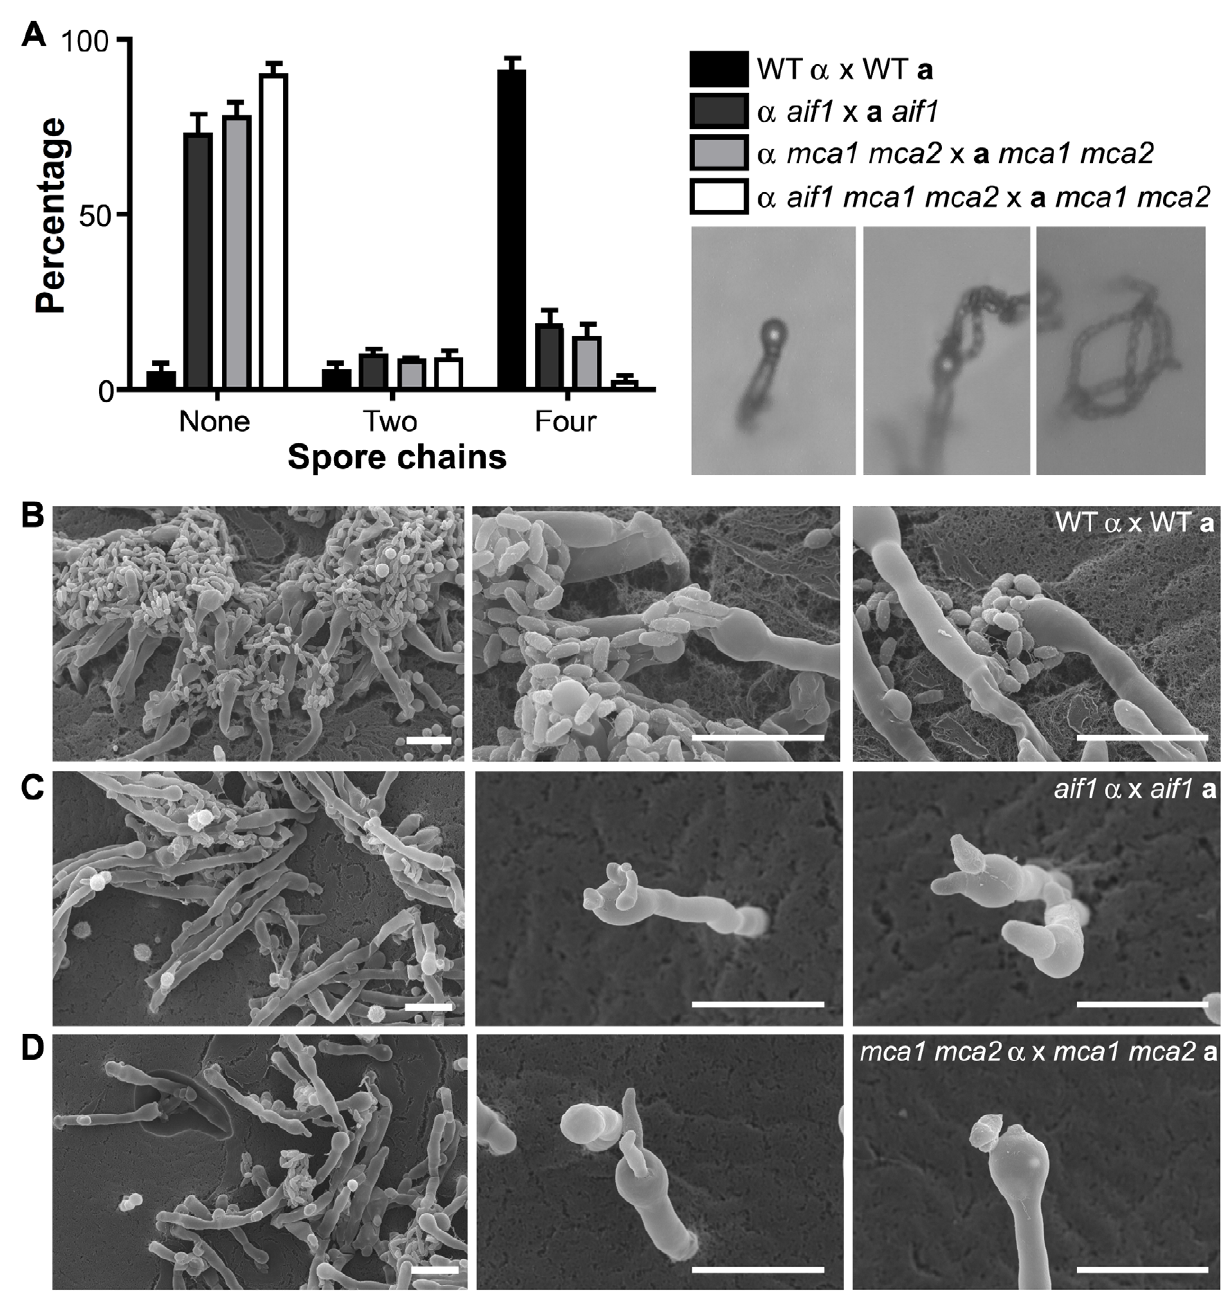
Figure 6. Apoptotic-defective mutants show defective basidiospore formation. A . Sporulation defects were observed in bilateral matings between a and a strains: H99 x KN99 a ; CPS3 x CPS15; YPH104 x CPS13; and CPS89 x CPS116. Basidia with zero, two or four spore chains formed after 14 days on MS media were counted using 40X microscopy (inset shows representative images). B-D . Scanning electron microscopy images of the wild-type H99 x KN99 a ( B ), aif1 x aif1 mutant CPS3 x CPS15 ( C ), and mca1 mca2 x mca1 mca2 mutant YPH104 x CPS13 ( D ) crosses. Basidia and basidiospore chains are shown in greater detail in the middle and right panels. Bars, 10 m m.